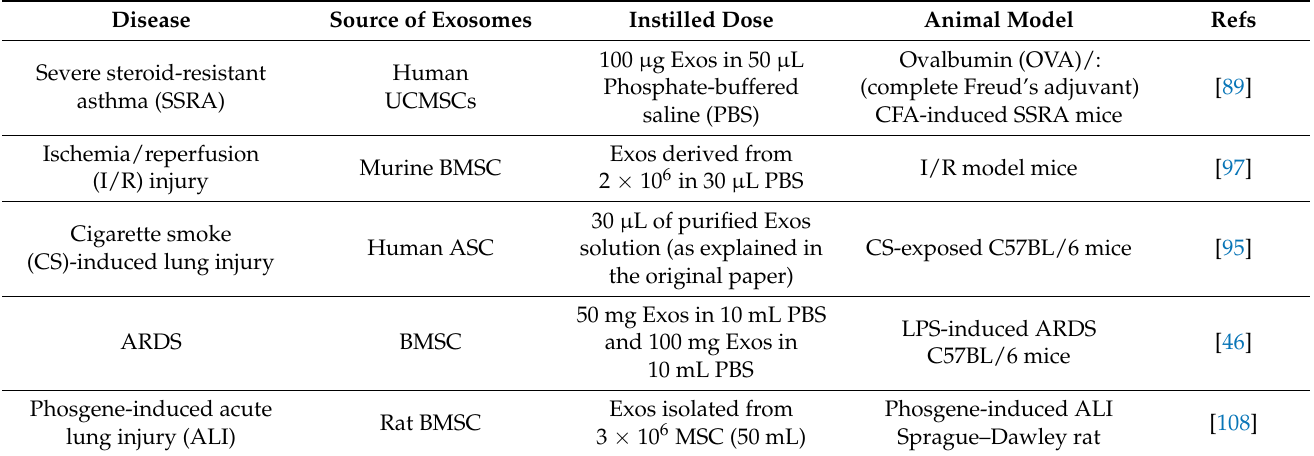
Table 2. Preclinical studies that used intratracheal instillation for delivering SC-Exos.